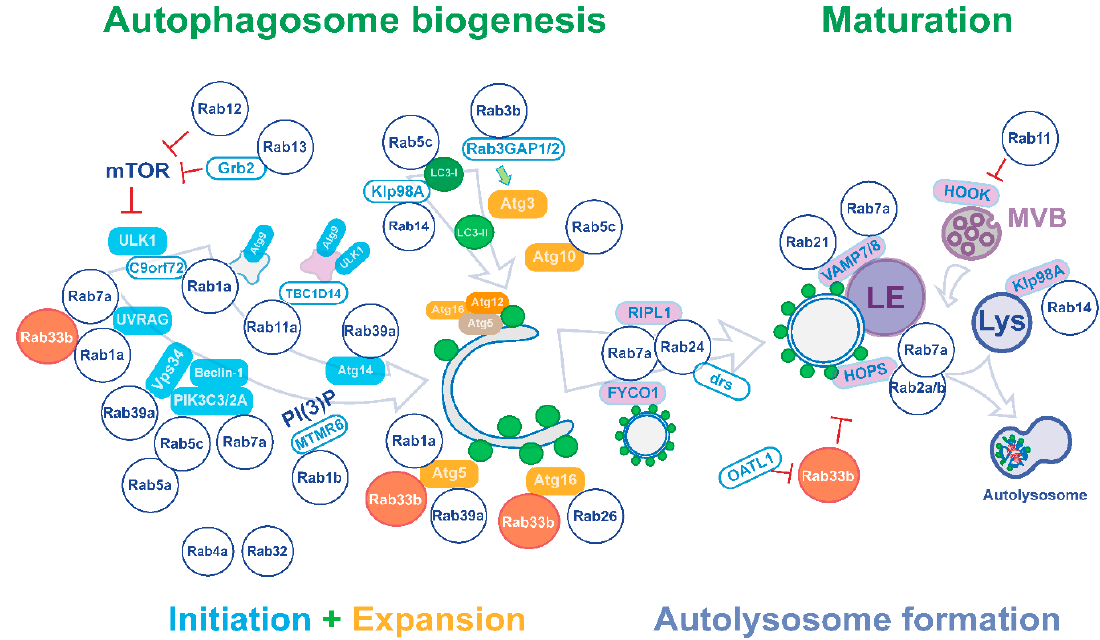
Figure 1. Regulation of the autophagy pathway by Rab proteins. Sequential steps of autophagy (from left to right) involve members of the Rab GTPase protein family that regulate this pathway through their e ff ectors. Biogenesis of autophagosomes is driven by autophagy proteins that promote initiation of isolation membrane (IM) formation (light blue) and subsequently sustain expansion of IM structures (orange). Maturation steps occur following transport and ultimate fusion of mature autophagosomes with membranes of the endo-lysosomal system (light violet) including multivesicular bodies (MVBs), late endosomes (LEs) and mature lysosomes (Lys). The involvement of Rab proteins at di ff erent stages of the autophagy pathway is represented as direct interaction of a given Rab with proteins that control the autophagy pathway (solid colour rectangles), indirect interaction with autophagy proteins through a Rab e ff ector (white rectangles) or as a means of functional regulation (inhibition or stimulation arrows). Rab33b (indicated in red) contributes to multiple steps of the autophagy pathway through distinct e ff ectors (i.e., UVRAG, Atg5, Atg16L, OATL1), which supports IM initiation and expansion at early stages, and is eventually involved in later stages of autophagosome maturation via modulation of the fusion of autophagosomes with